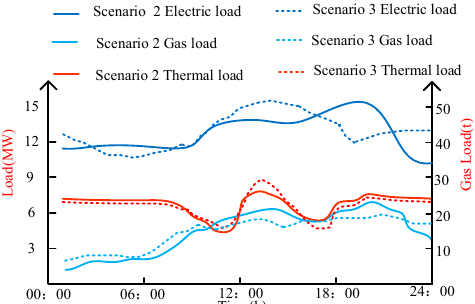
Figure 7. Actual load under Scenario 2 and Scenario 3.